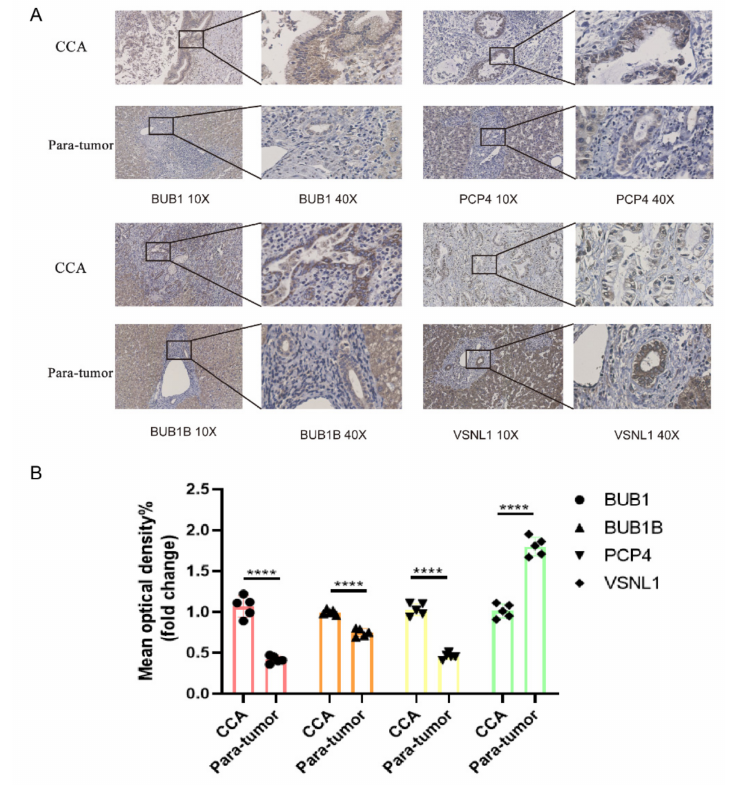
Figure 8. Verification of hub genes. ( A ) Immunohistochemical staining of CCA and adjacent tissue samples. Blue indicates nuclear staining, and brown indicates target protein staining. The darker the brown, the more the target protein was expressed. The expression of BUB1, BUB1B, and PCP4 were significantly increased in CCA patient tissue, but the protein level of VSNL1 was significantly lower in CCA tissue. ( B ) Mean optical density of the expression of BUB1, BUB1B, PCP4, and VSNIL1 of cholangiocarcinoma cells in CCA and bile duct cells in adjacent tissue samples. Staining areas within normal hepatocytes were excluded. **** p <